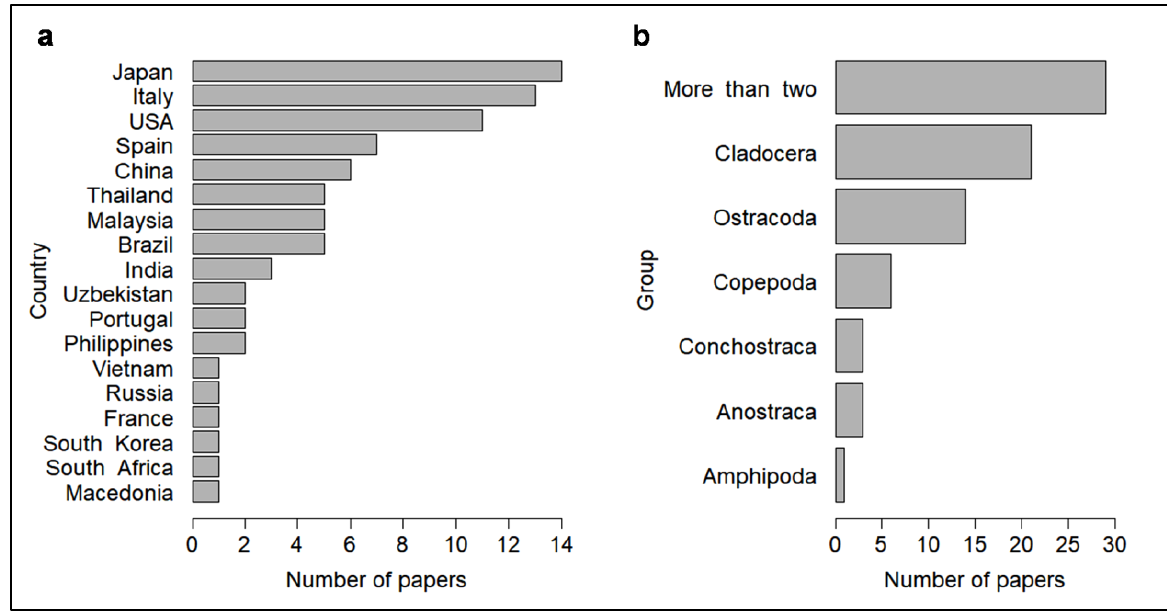
Figure 3. Number of studies with microcrustaceans in rice fields in the Web of Science and Scopus databases between 1977 and 2019: ( a) countries studied and ( b) groups of microcrustaceans. USA = United States of America. More than two = more than two groups of microcrustaceans studied (e. g. Cladocera, Copepoda and Ostracoda in the same